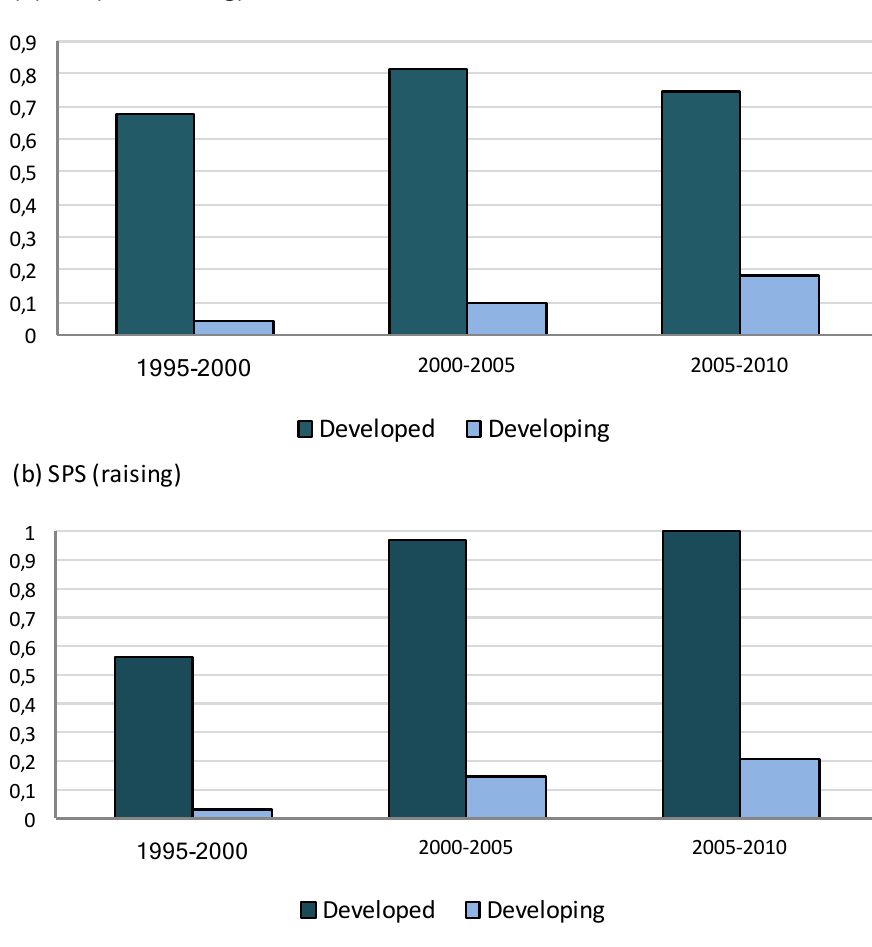
Figure 2. # SPS Specific Trade Concerns (STC) “Maintaining” and “Raising” countries as a share of the total number of countries by the level of